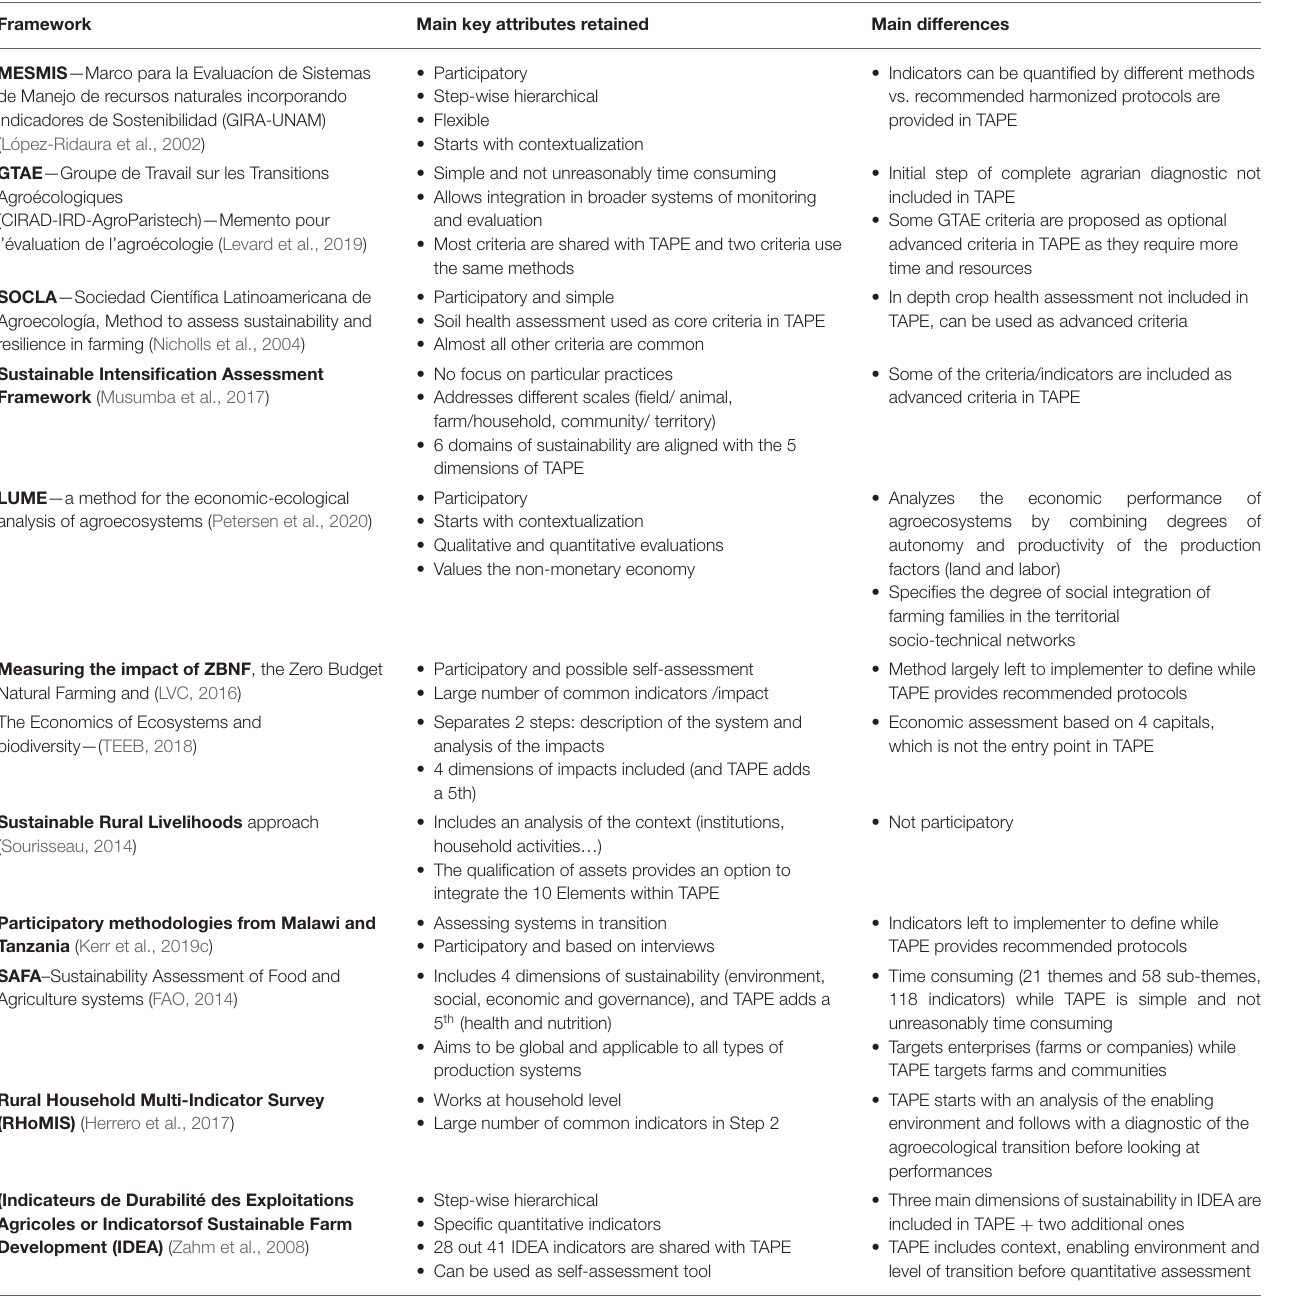
TABLE 1 | Main key attributes retained from a number of existing frameworks reviewed and main differences between those frameworks and TAPE.